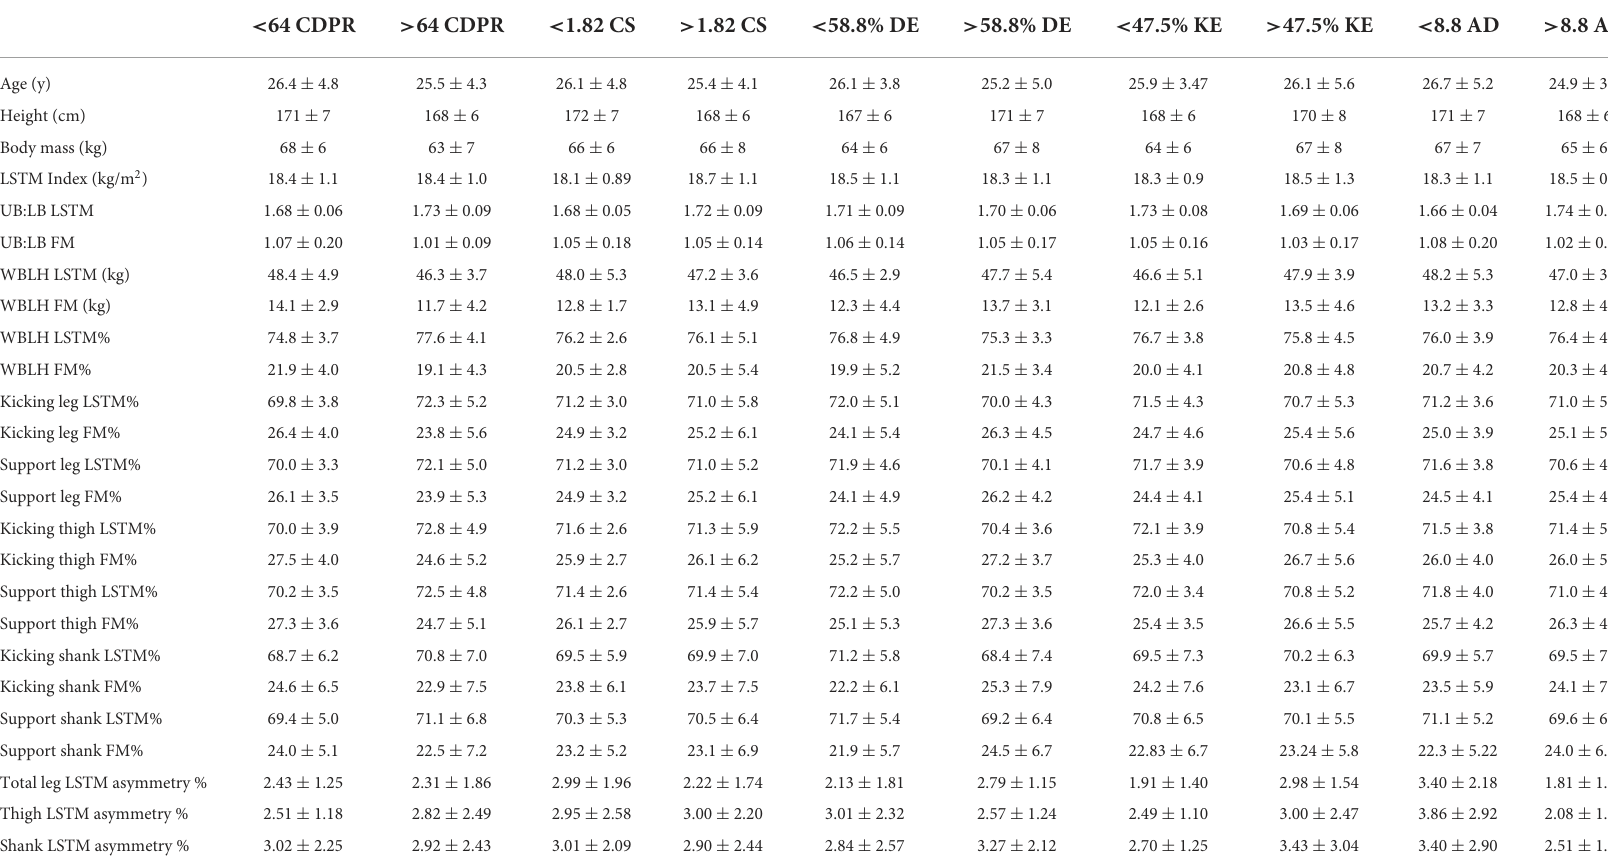
TABLE 2 Differences between players according to a median split for match performance variables (Champion Data Player Rank, coaches score, disposal efficiency, kicking efficiency, and average